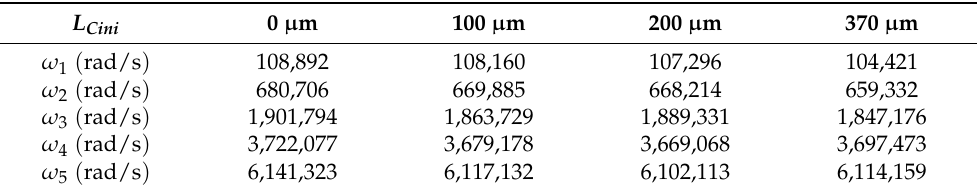
Table 2. The natural frequency values when adsorbate located at various positions on the resonator.